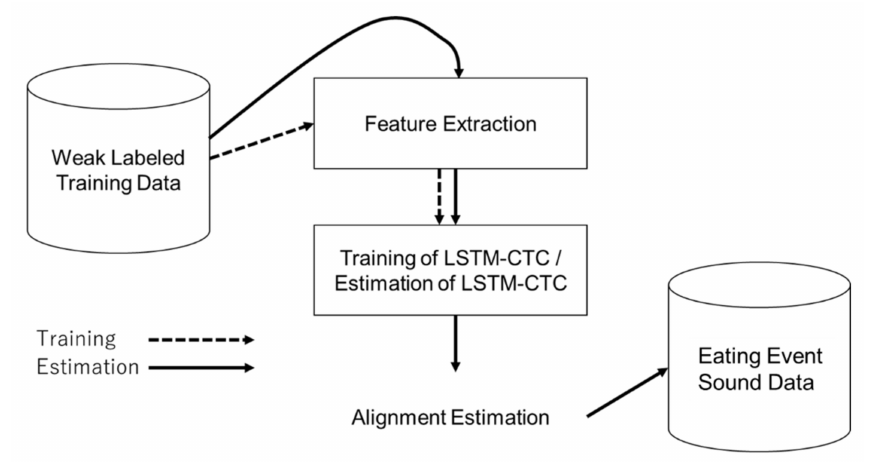
Figure 6. Division of event sound data using weak labeled